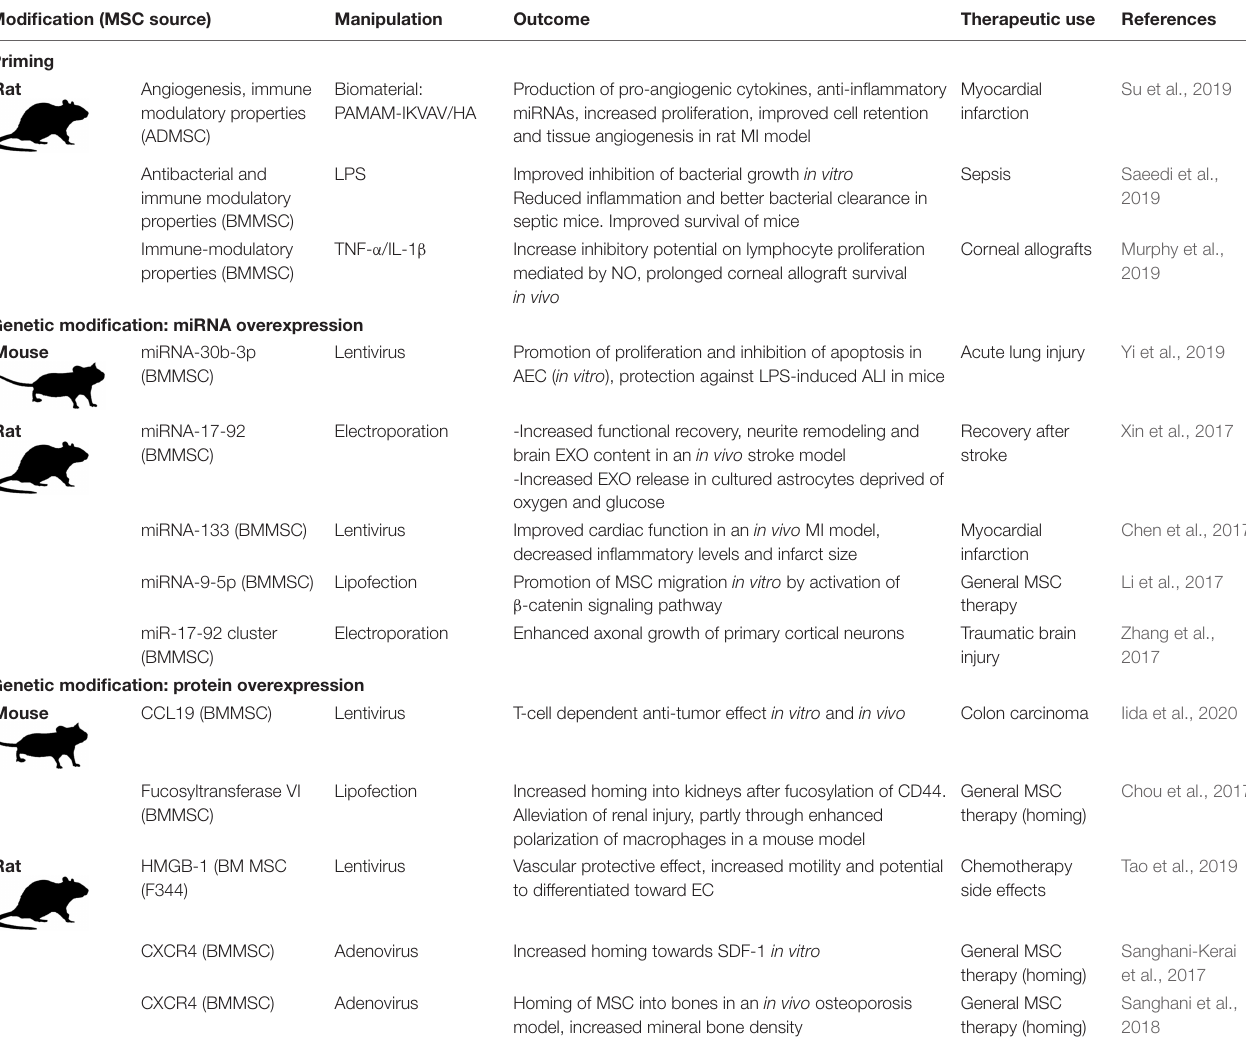
TABLE 4 | Manipulation of laboratory rodent MSCs to optimize the therapeutic effects of the MSC